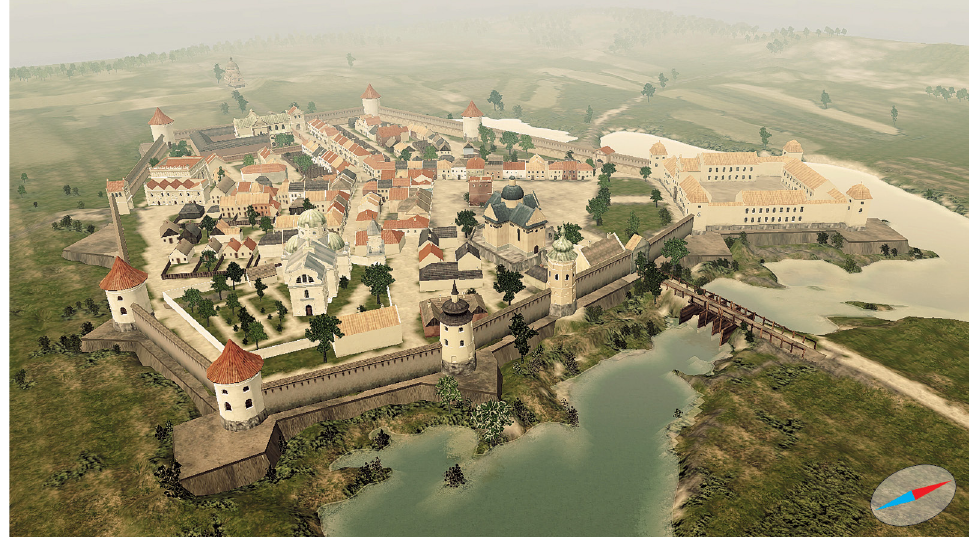
Fig. 5. Zhovkva XVIII (Ukraine) – Shtetl Routes 3D mock-up (sample) (source: